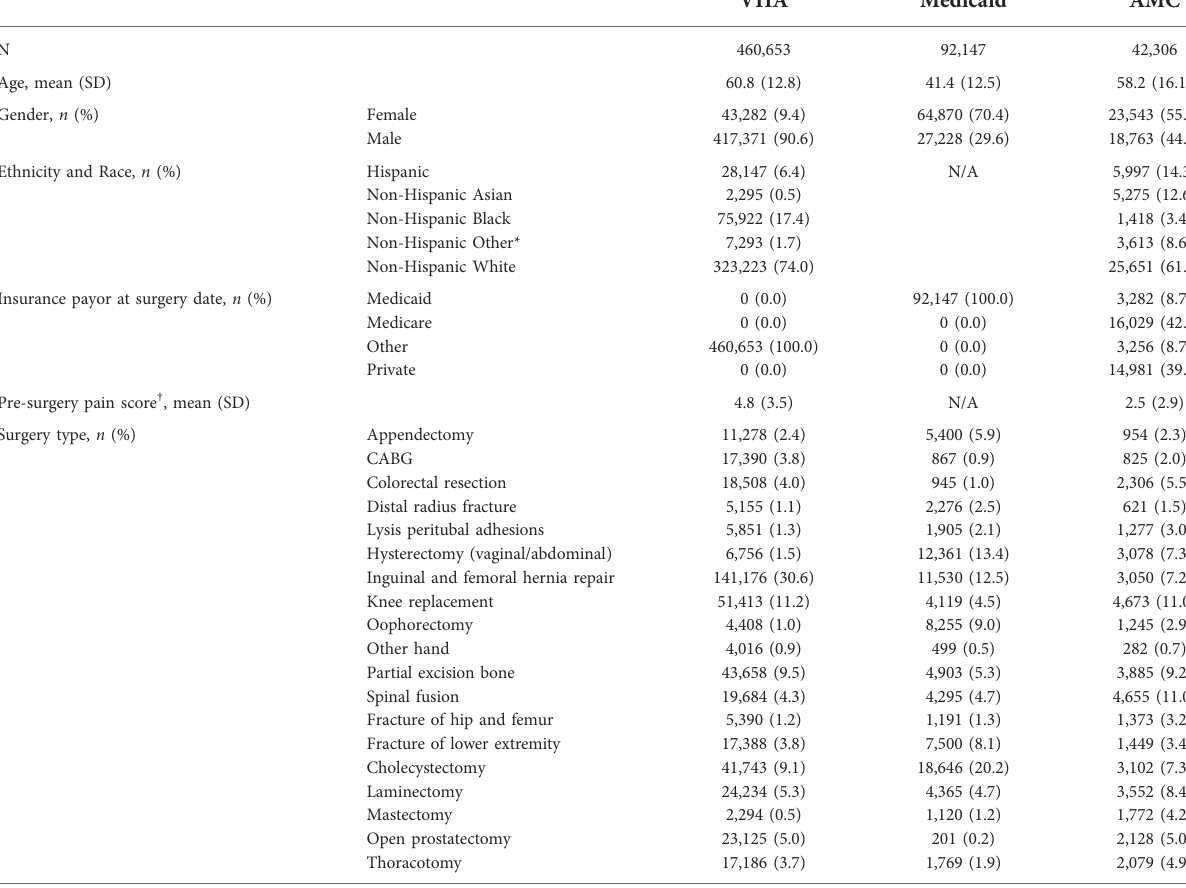
TABLE 1 Demographic and clinical characteristics of surgical patients strati fi ed by healthcare system +